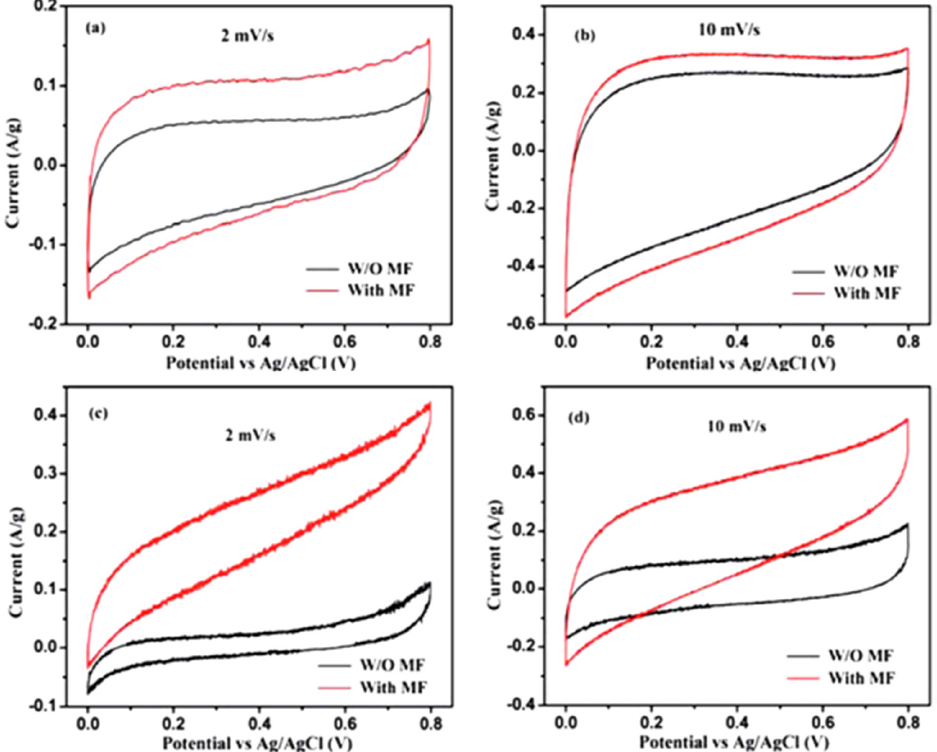
Figure 18. CV curves of ( a , b ) Fe 2 O 3 and ( c , d ) Fe 2 O 3 /graphene. Reproduced with permission from [145] Copyright (2012) Royal Society of Chemistry.